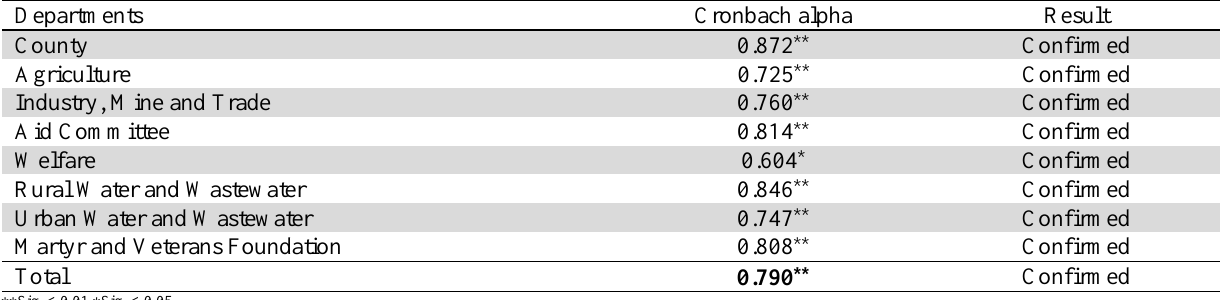
Correlation test between mission culture and organizational success in all departments of Khorasan Razavi